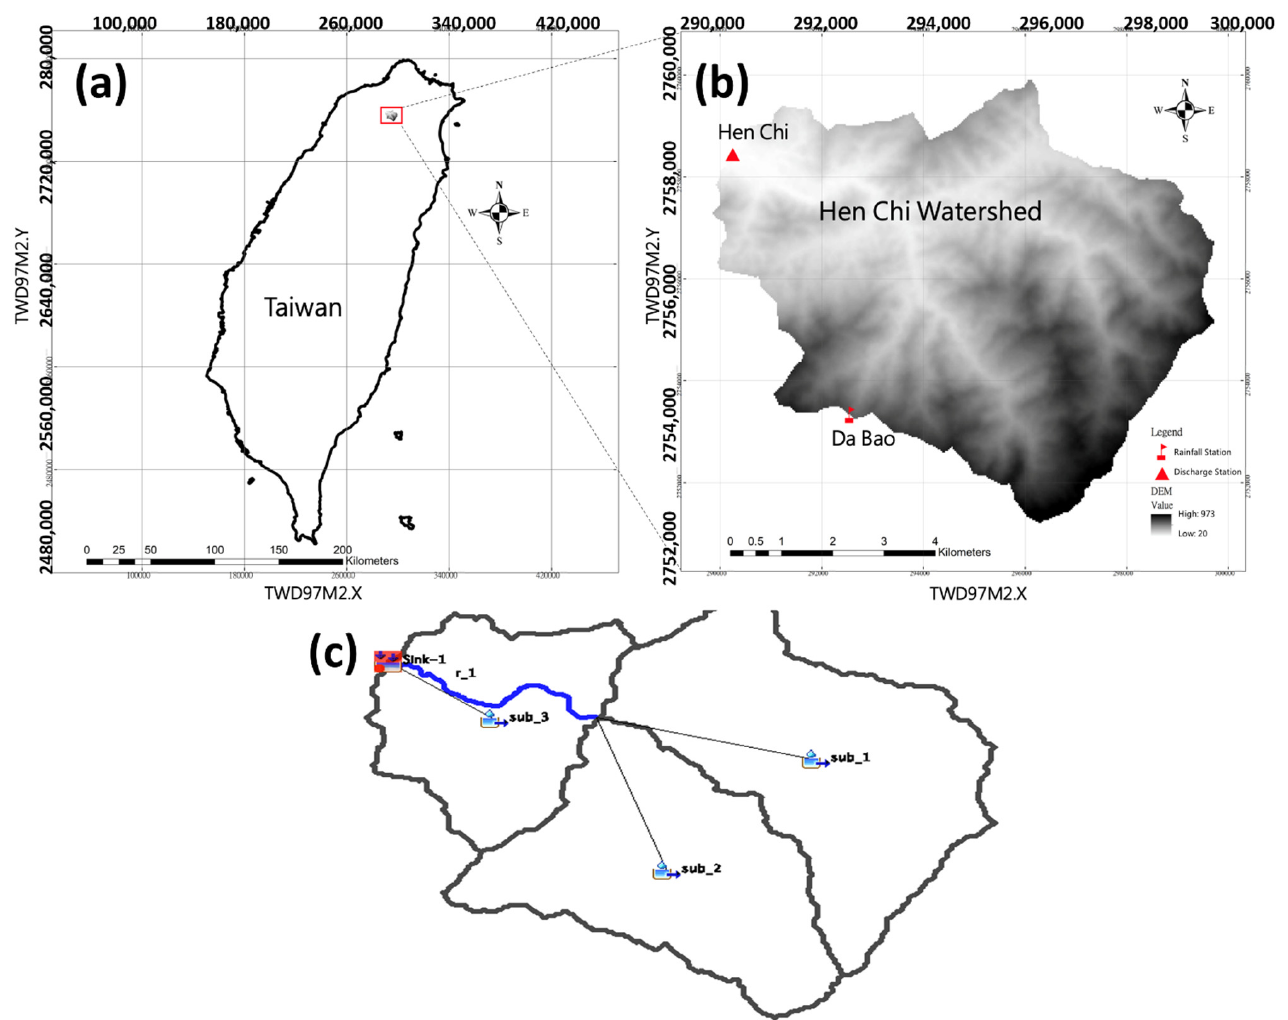
Figure 1. ( a ) the location of the studied watershed in Taiwan, ( b ) the elevations of the studied watershed, and the position of the rainfall and water level gauging stations, and ( c ) the distributions of elements divided in the HEC-HMS model for the studied watershed (Hen Chi watershed).